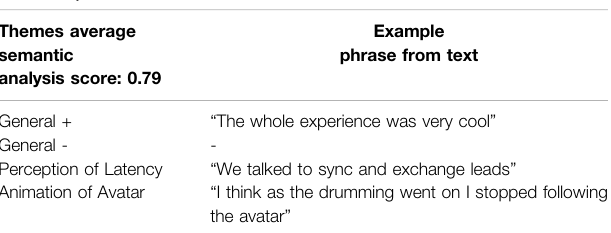
TABLE 5 | Cluster